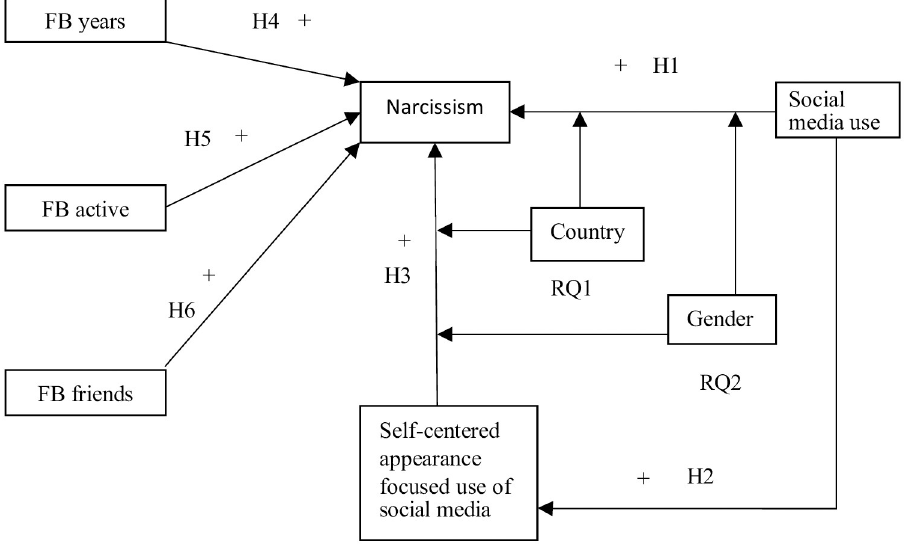
Fig 1. Model of narcissistic social media usage. Moderators are gender and